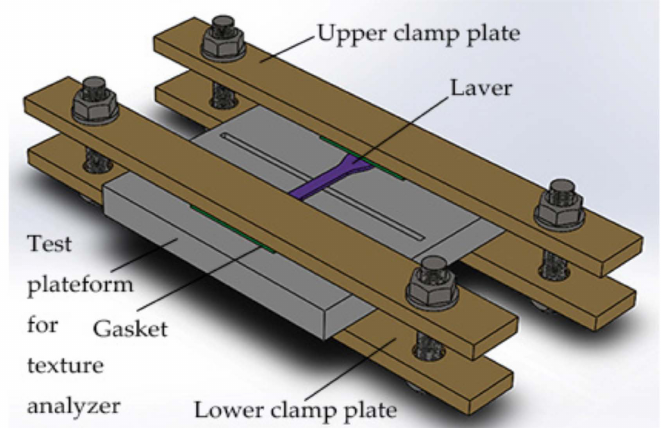
Figure 4. Clamp for the shear